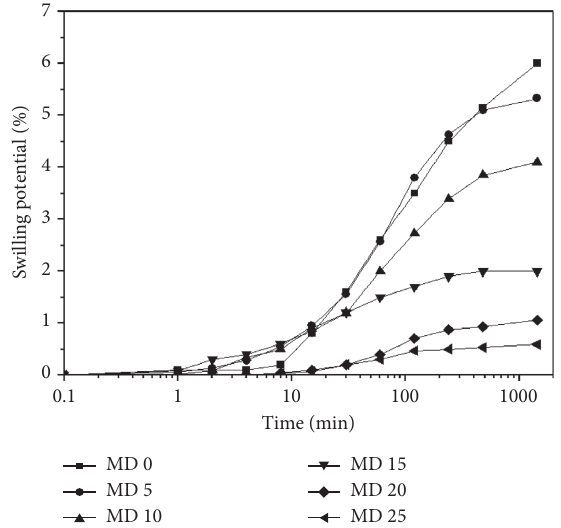
Figure 13: Axial swelling ratio versus time for different percentages of MD.